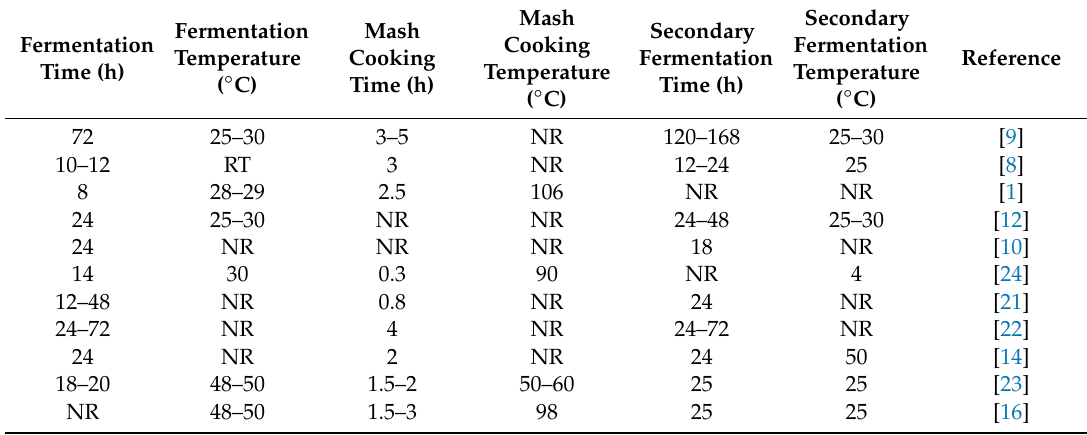
Table 2. Available literature of processing conditions for umqombothi